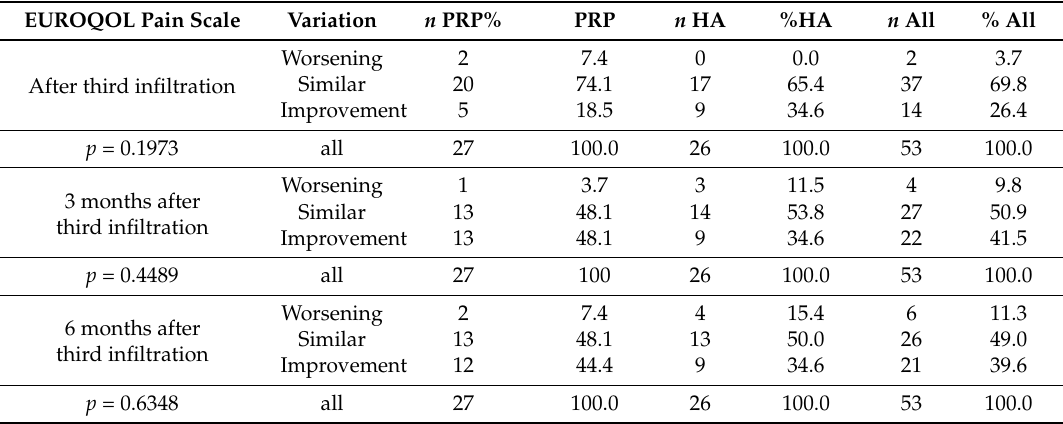
Table 5. EUROQOL Scale Score, comparison between PRP and HA groups. EUROQOL Pain Scale